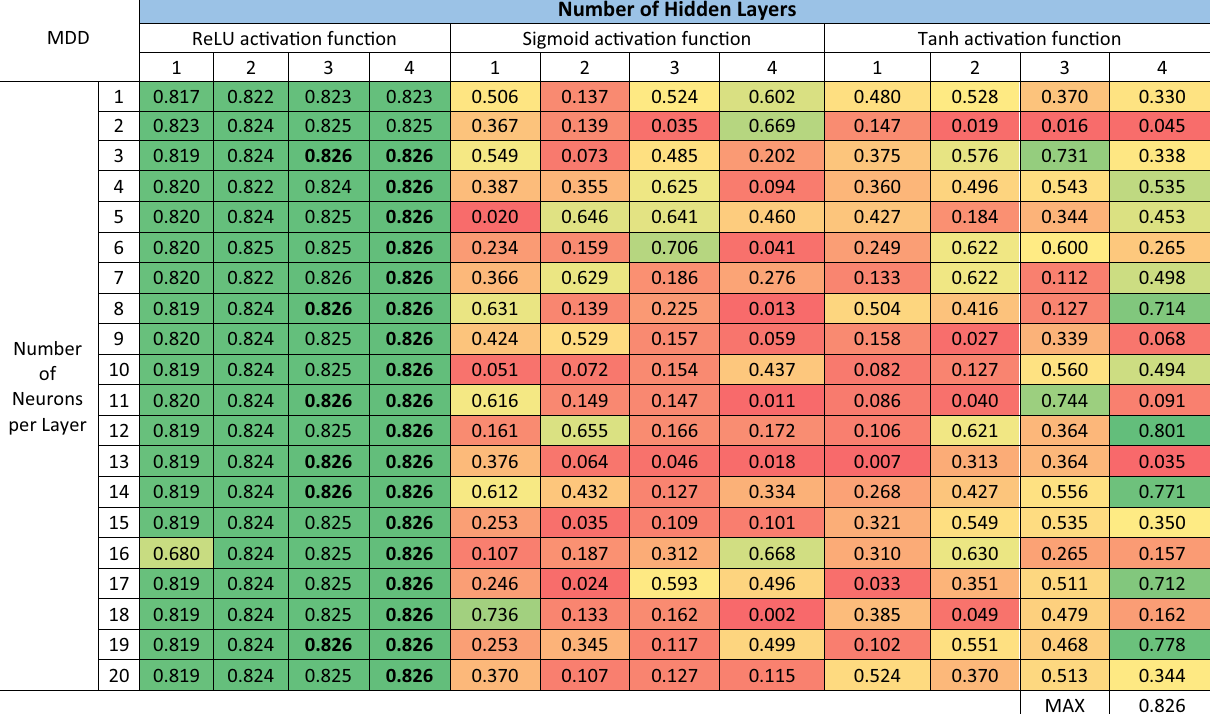
Number of Hidden Layers